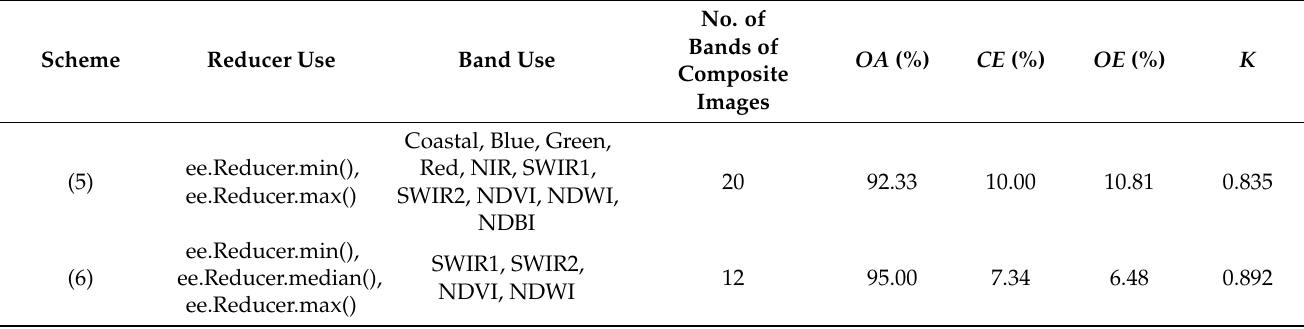
Table 5. Accuracy evaluation of the other two schemes in